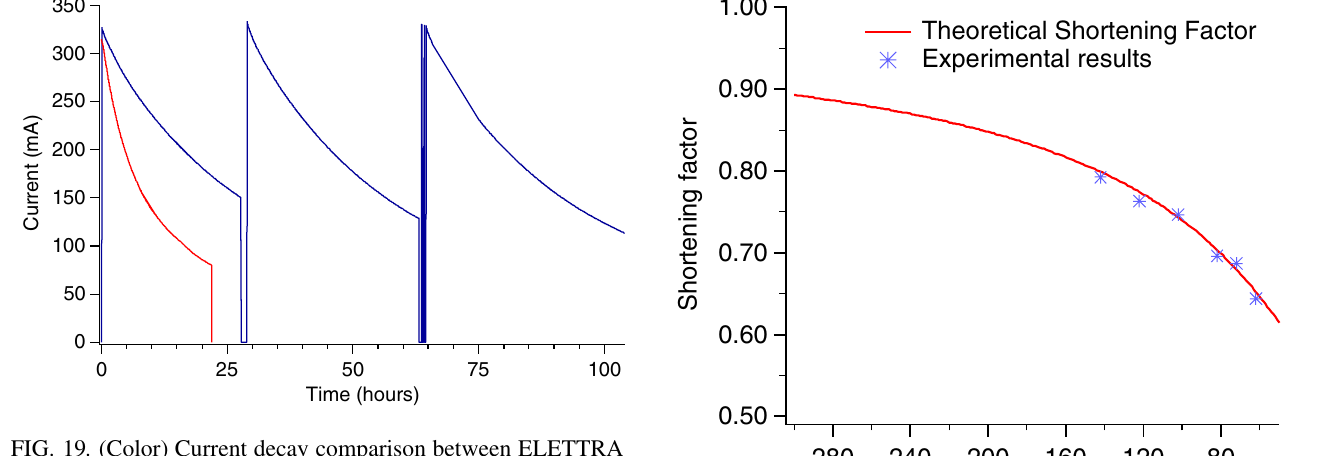
FIG. 19. (Color) Current decay comparison between ELETTRA operation with 3HC not active (red line) and with 3HC tuned (blue line). In this second case the interval between two sub- sequent injection is about 36